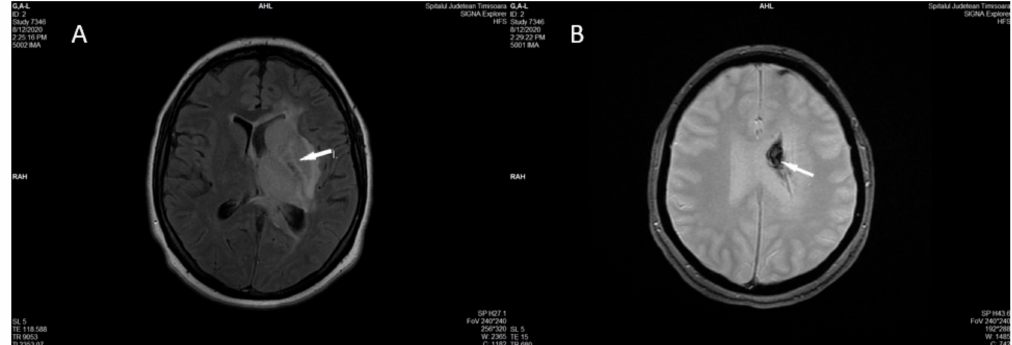
Figure 3. Non-contrast head MRI performed in the acute phase shows venous infarction (I in FLAIR) in the left thalamus, left basal ganglia, and left external and internal capsula ( A ) with hemorrhagic transformation (arrow in Axial T2 Gradient Echo) in the corpus of the left caudate nucleus ( B ).